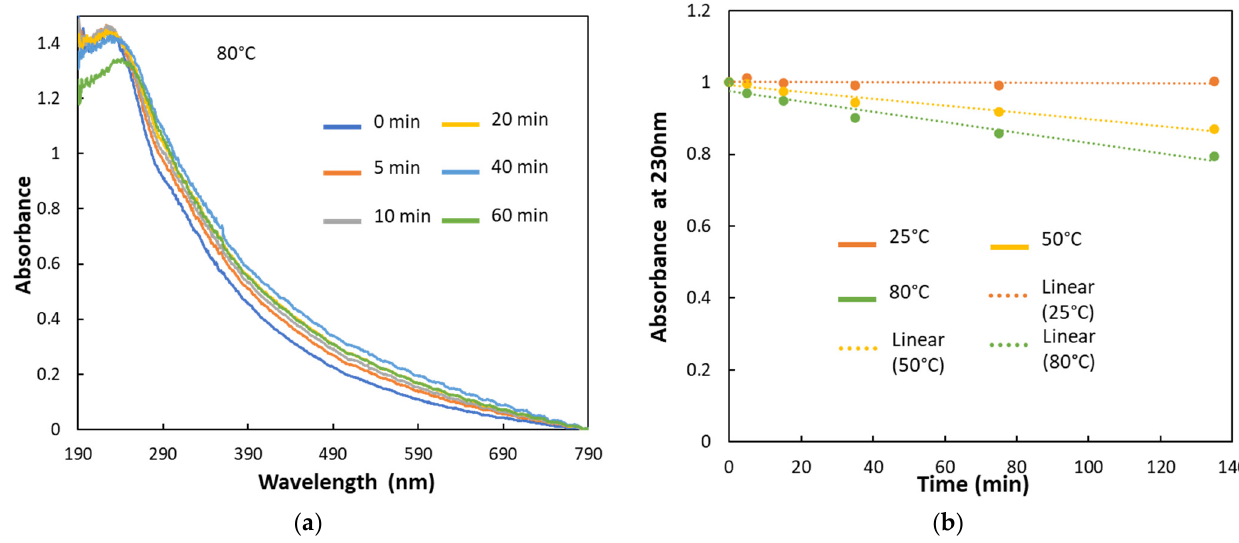
Figure 4. ( a ) Time evolution of absorbance spectra for the film immersed in ultrapure water at 80 ◦ C; ( b ) normalized absorbance values at 230 nm as a function of the immersion time of (PEI/GO) 12 films in water at constant temperature, namely 25, 50 or 80 ◦